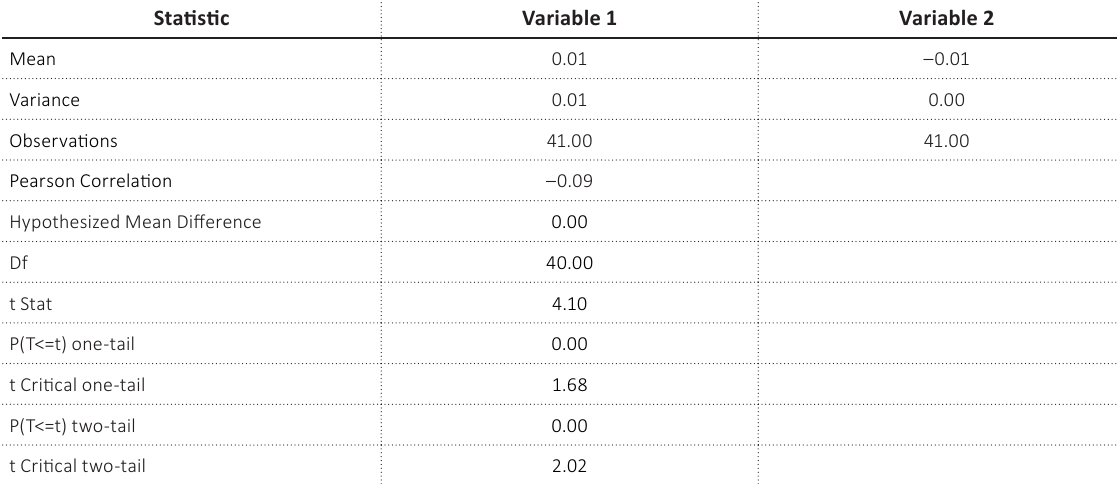
Table 6. T -test results (equally-weighted portfolio)